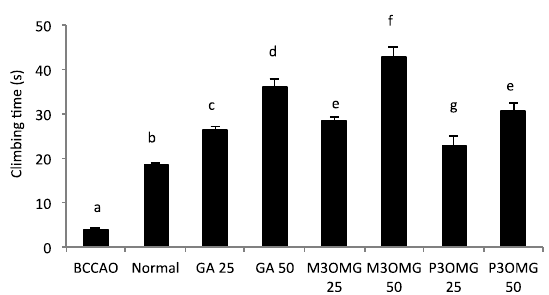
Figure 2. Volume of water ( A ) and sucrose solution ( B ) consumption in the stroke ‐ induced anhedonia model. Data are shown as a mean (mL) ± SD ( n = 3); different letters indicate statistically significant differences ( p < 0.01) between the two groups.